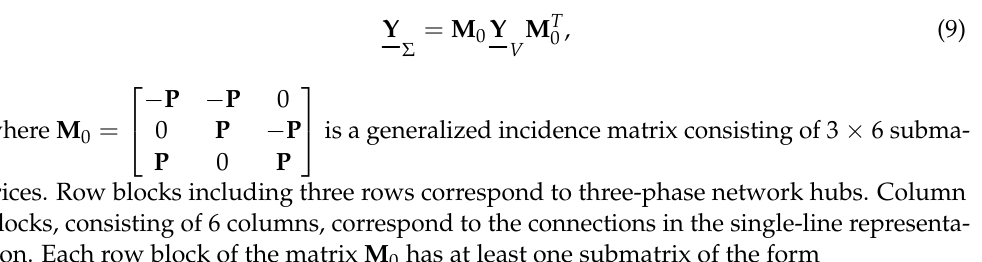
Figure 5. Original circuit of the power transmission line.